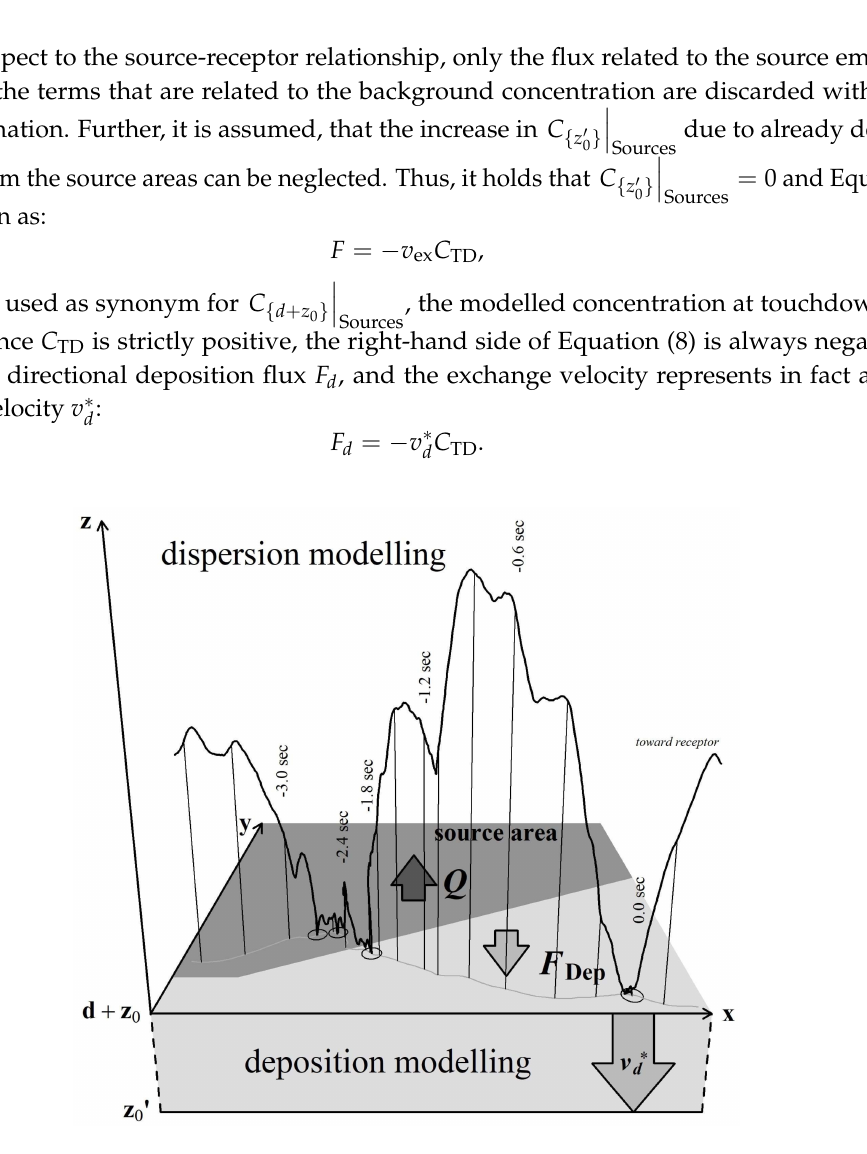
Figure 1. Illustration of the deposition modelling in the bLSmodelR . The trajectory touchdowns (indicated by circles) at − 2.5 s and − 2.7 s are inside the source area and not affected by deposition modelling; those at − 1.9 s and 0.0 s are outside the source area where deposition occurs in the